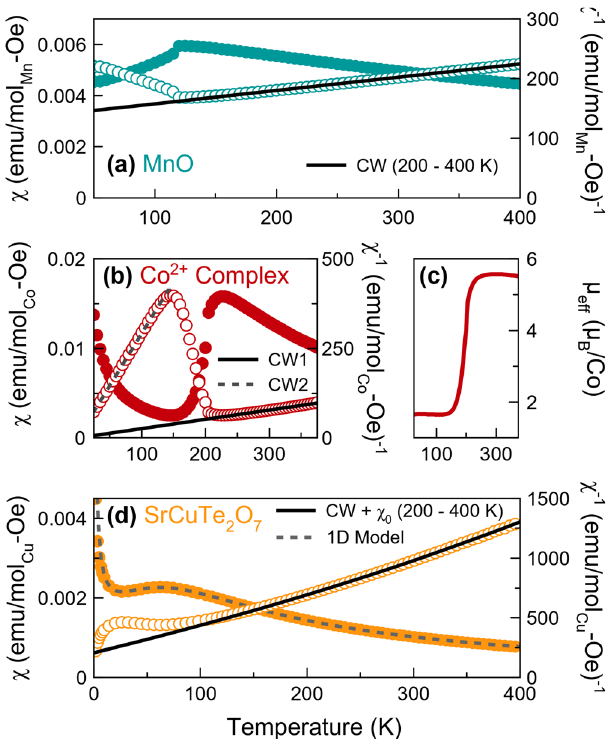
Fig. 7 Representative examples of Curie – Weiss behavior in 3 d transition metal magnets. The magnetic susceptibility (left axis, fi lled symbols) and inverse magnetic susceptibility (right axis, open symbols) normalized per mole of transition metal for a MnO measured in a fi eld of H = 1000 Oe, which is well- fi tted by a standard Curie – Weiss (CW) law, b reproduced data for Co(tmeda)(3,5-DBQ) 2 ⋅ 0.5C 6 H 6 measured in a fi eld of H = 5000 Oe 38 , which is an organic Co 2 + complex that undergoes a crossover from high-spin to low-spin just below 200 K with two distinct Curie – Weiss regimes. c shows the temperature dependence of μ eff ¼ ffiffiffiffiffiffiffiffi p 8 χ T as a function of temperature, which is the conventional way of presenting susceptibility data for a spin crossover complexes, and d SrCuTe 2 O 7 measured in a fi eld of H = 10, 000 Oe, which is well- fi tted by a Curie – Weiss law at temperatures above 200 K but exhibits an anomaly characteristic of 1-dimensional interactions at lower